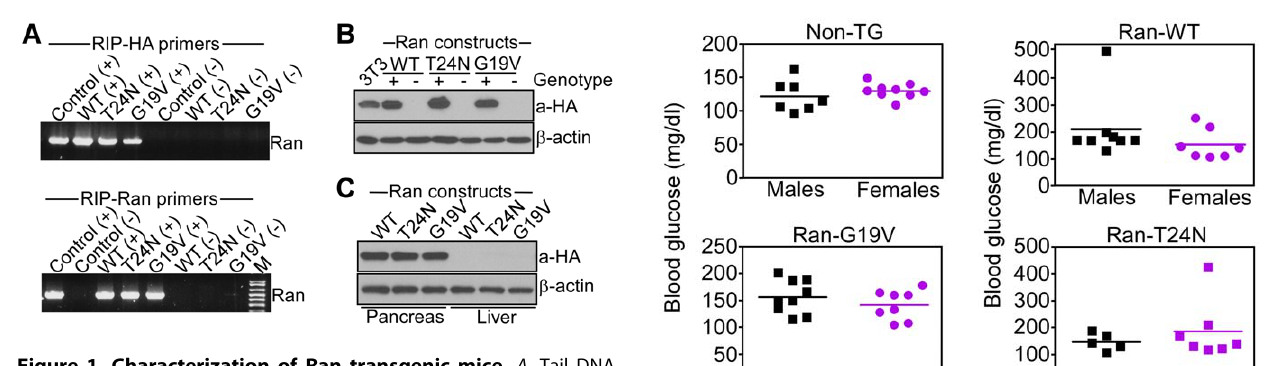
Figure 1. Characterization of Ran transgenic mice. A , Tail DNA was extracted from transgenic mouse lines expressing Ran-WT, Ran T24N or Ran G19V in pancreatic b cells under RIP control, and PCR products were amplified using RIP-HA ( top ) or RIP-Ran ( bottom ) primers. ( + ) or ( 2 ) refers to Ran-positive or –negative genotype, or positive or negative control primers for the amplification reaction. M, molecular weight markers. B , Pancreas tissues extracted from the various mouse cohorts genotyped for the presence ( + ) or absence ( 2 ) of Ran transgenes were analyzed by Western blotting. 3T3, extracts from NIH3T3 cells transiently transfected with HA-Ran cDNA used as control. a-HA, antibody to HA. C : Pancreas or liver tissues were isolated from PCR-confirmed Ran transgenic mice, and analyzed by Western blotting.